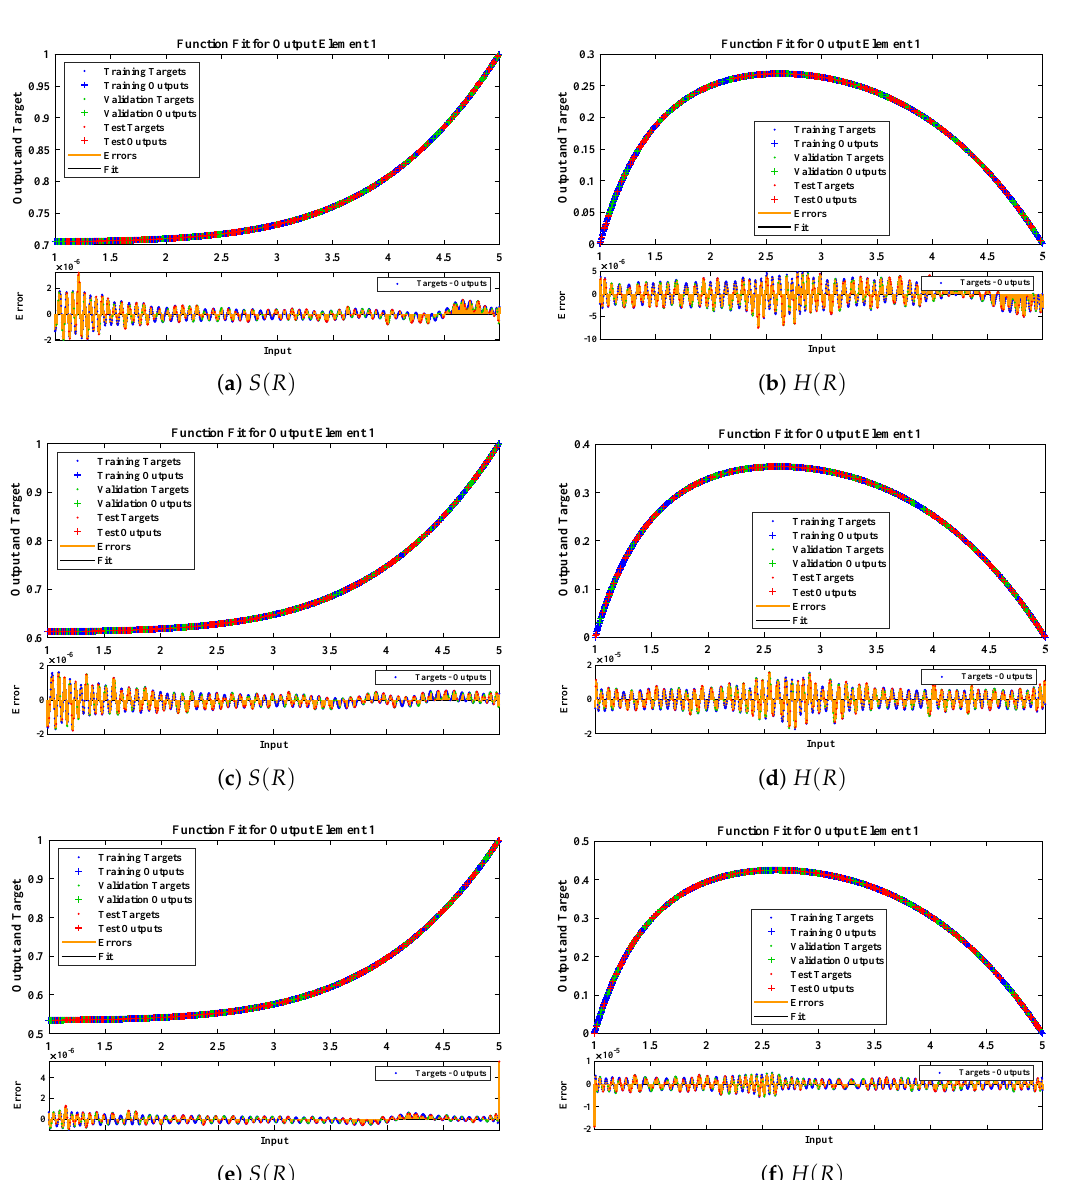
Figure 7. Comparison of approximate solutions obtained by NNs–LMT with numerical solution for different cases of